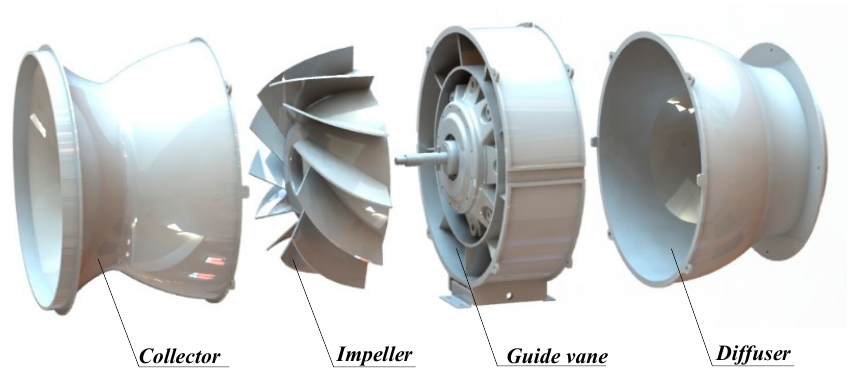
Figure 2. A structure diagram of a small diagonal flow fan.